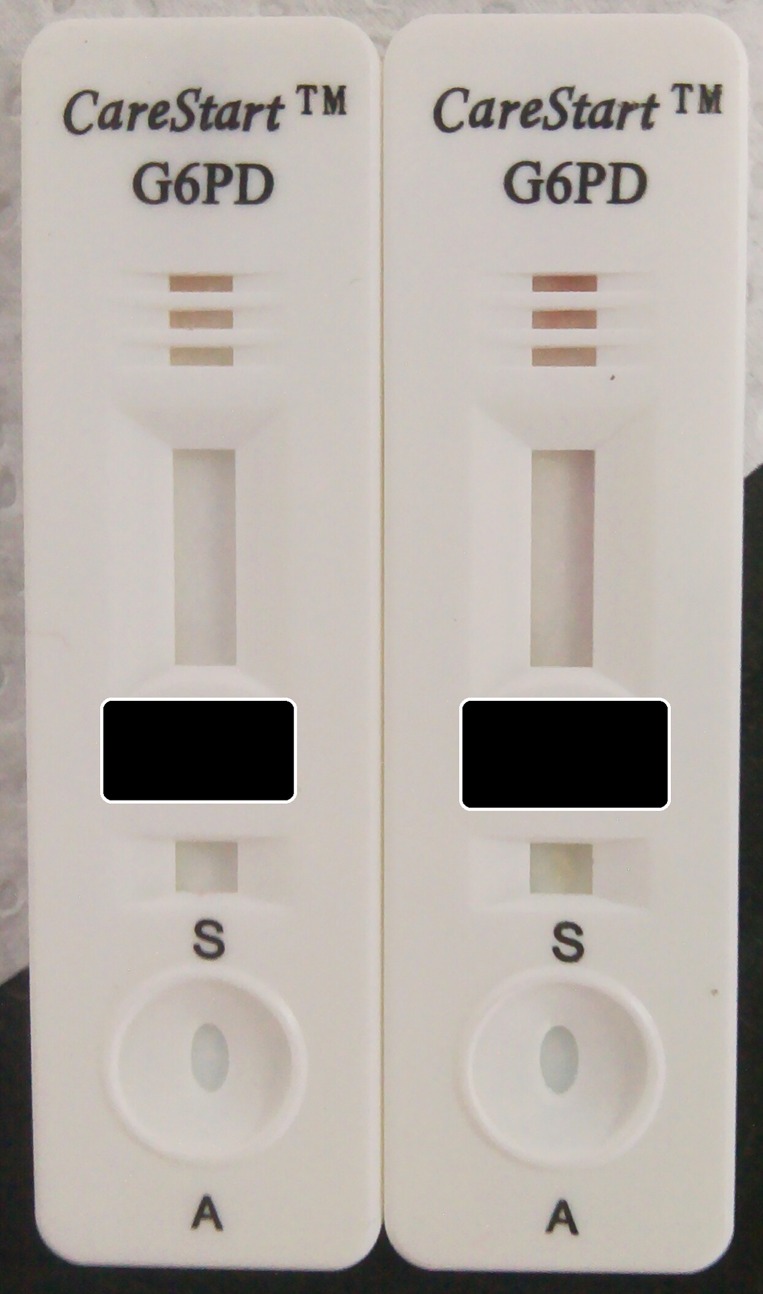
Example of samples from a G6PD deficient male (left, G6PD activity = 1.21 IU/gHb) and G6PD normal male (right, G6PD activity = 7.18 IU/gHb) that were both diagnosed as deficient using the CST test.